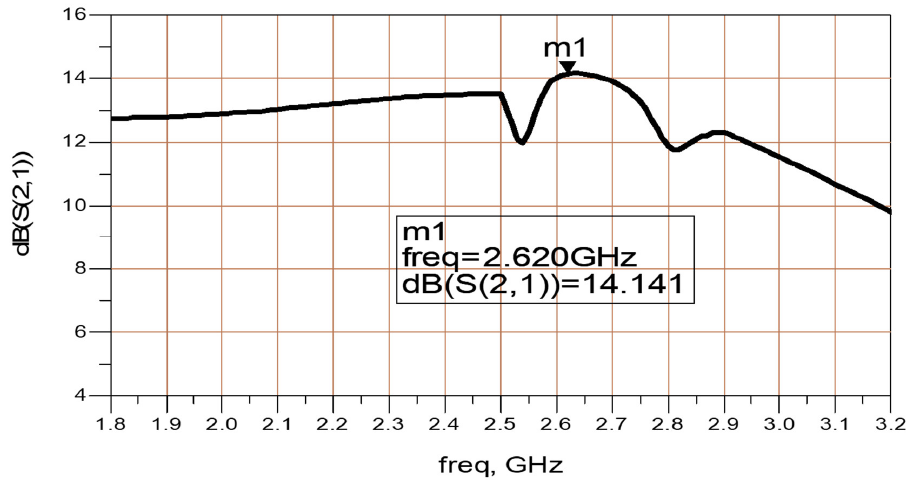
Figure 22. S21 parameters of the circular polarized transmitting channel.